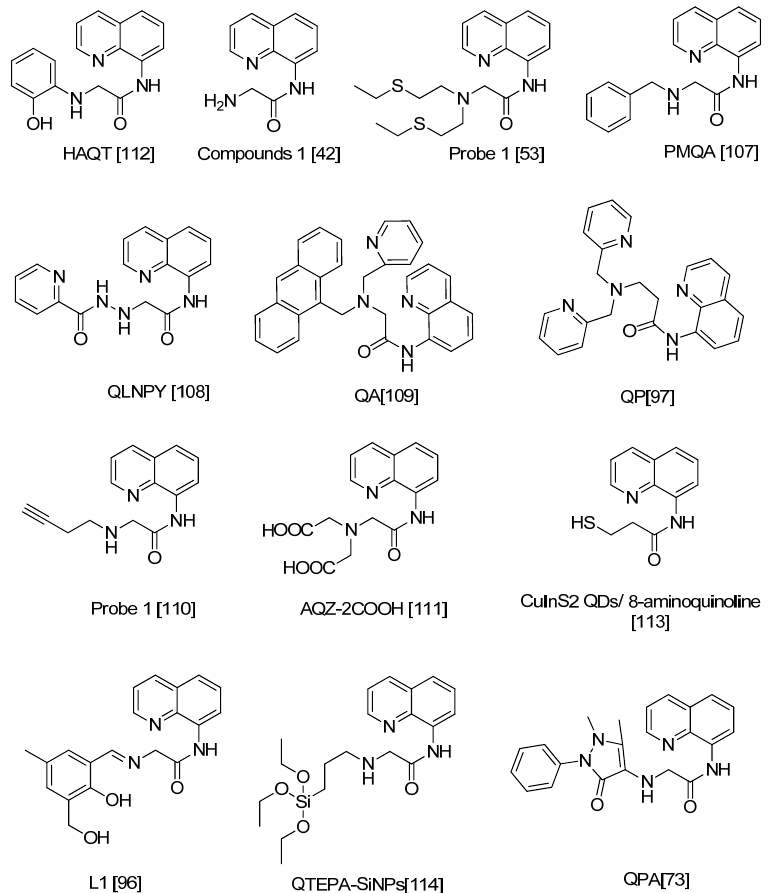
Figure 9. Chemical structures of 8-carboxamidoquinoline derivatives based on Table 2.